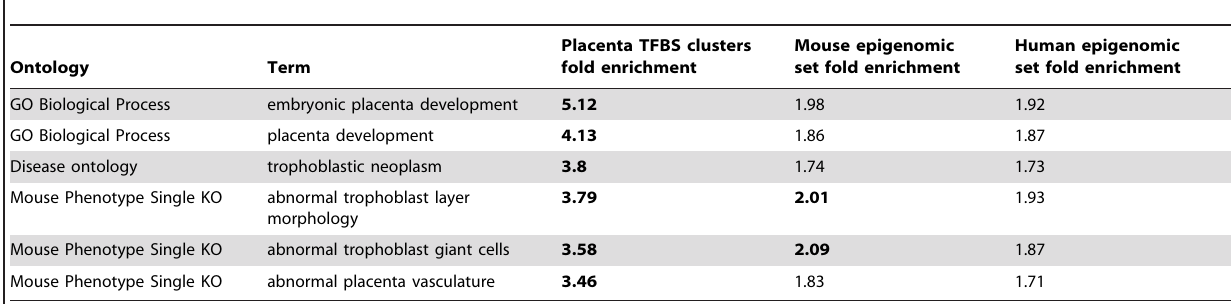
Table 1. GREAT enrichments for placenta TFBS clusters, mouse placenta epigenomic set, human placenta epigenomic set.